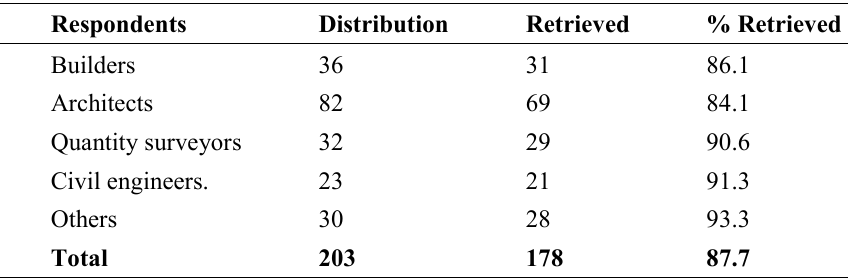
Table 1. Questionnaire Distribution and Retrieval